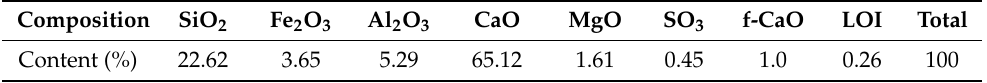
Table 1. Chemical composition of cement clinker.